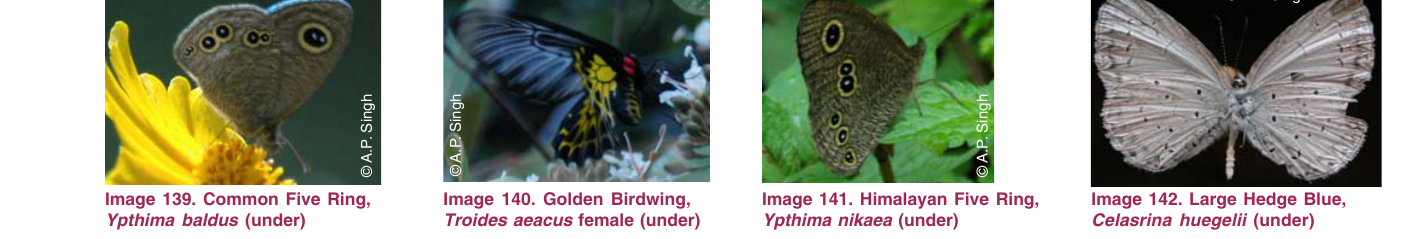
Image 140. Golden Birdwing, Troides aeacus female (under)